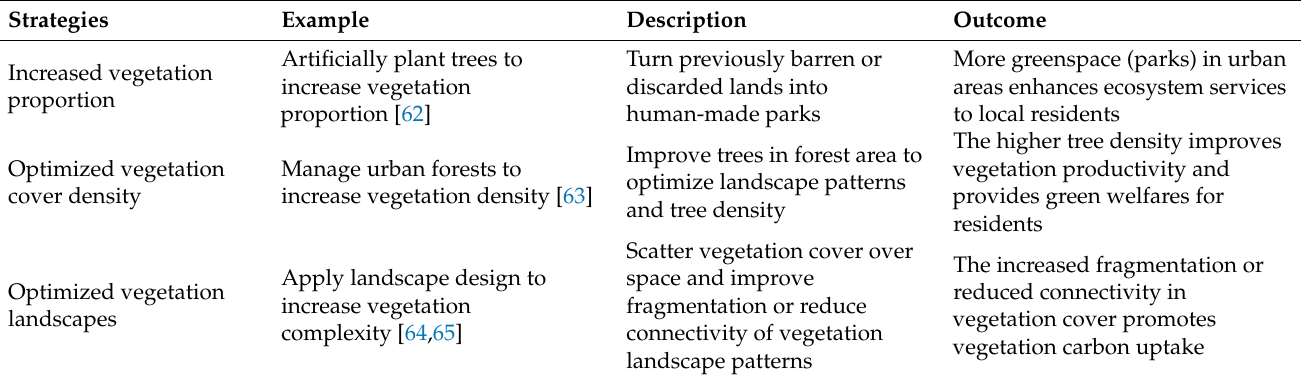
Table 4. Urban vegetation management to improve vegetation carbon